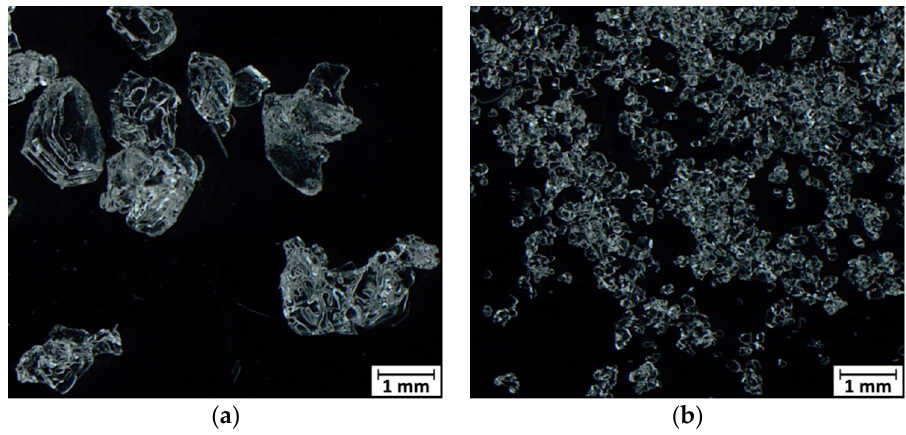
Figure 4. Stereo-microscopy pictures of ( a ) natural and ( b ) natural-like snow grains.